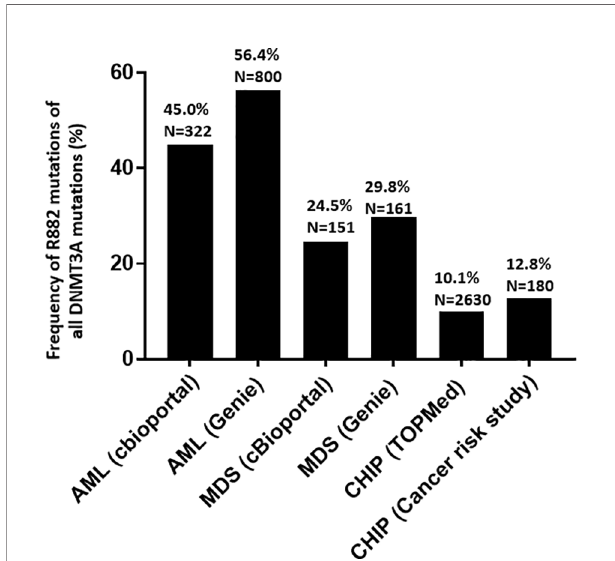
FIGURE 1 | Frequency and distribution of DNMT3A mutations (R882 versus non-R882) in acute myeloid leukemia (AML), myelodysplastic syndrome (MDS), and clonal hematopoiesis of indeterminate potential (CHIP). GENIE database and myeloid studies available in cBioPortal were used for to retrieve DNMT3A mutations in patients with myeloid neoplasms. Two studies (7, 30) on clonal hematopoiesisof indeterminate potential (CHIP) were usedto retrieve DNMT3A mutationsin healthy individuals without